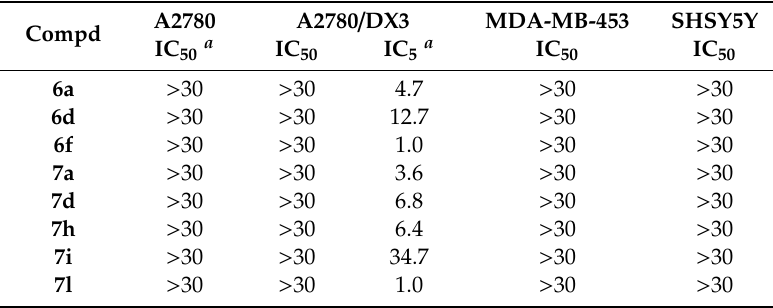
Table 3. IC 50 and IC 5 ( µ M) of compounds 6 and 7 in SHSY5Y, MDA-MB-453, sensitive A2780, and multidrug resistant A2780 / DX3